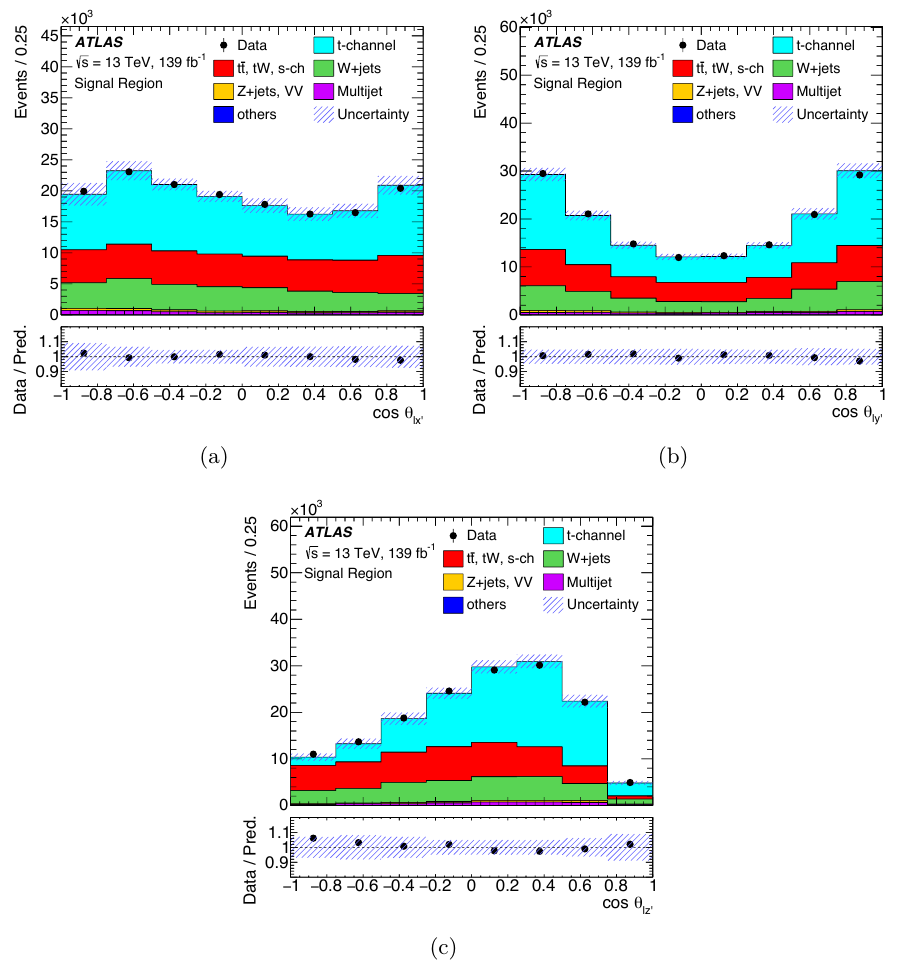
Figure 6 . Post-fit distributions of (a) cos θ ‘x 0 , (b) cos θ ‘y 0 and (c) cos θ ‘z 0 in the signal region. The data, shown as the black points with statistical uncertainties, are compared with SM signal and background predictions. The multijet background is estimated using MC and data-driven techniques, while contributions from simulated W + jets and top-quark background and t -channel signal event samples are normalised to the results of a maximum-likelihood fit to event yields in the signal and control regions. The label ‘others’ represents t ¯ tZ , t ¯ tW , tZq , tHq , and tWZ production. The uncertainty bands include both the statistical and systematic uncertainties. The lower panels show the ratio of data to prediction in each